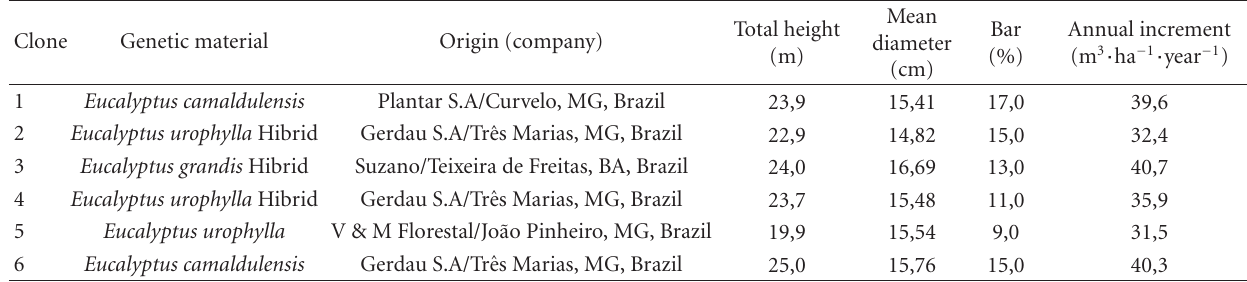
Table 1: General information about the di ff erent genetic materials of the